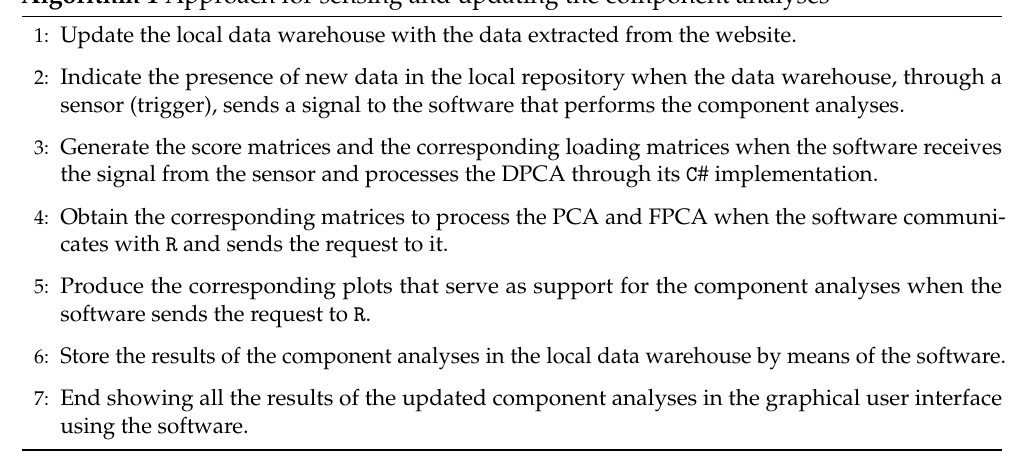
Algorithm 1 Approach for sensing and updating the component